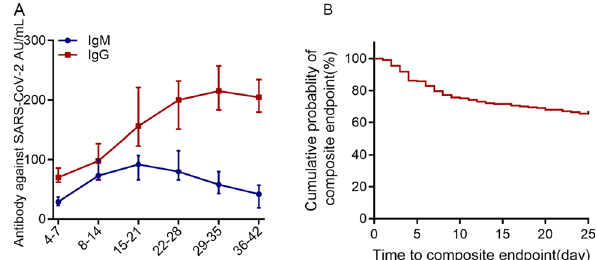
Figure 3. ( A ) The dynamic characteristics of IgM-IgG antibody levels. ( B ) Evaluation of the prognosis of COVID-19 patients via a Kaplan–Meier analysis. The composite endpoint (event) was ICU transfer or death within 25 days from the date of admission to the hospital. The cumulative event-free survival curve was plotted.